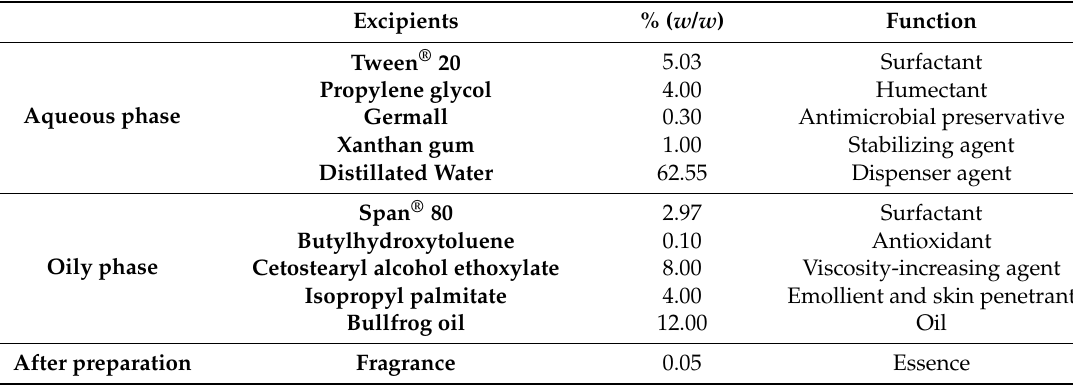
Table 4. Composition of the topical